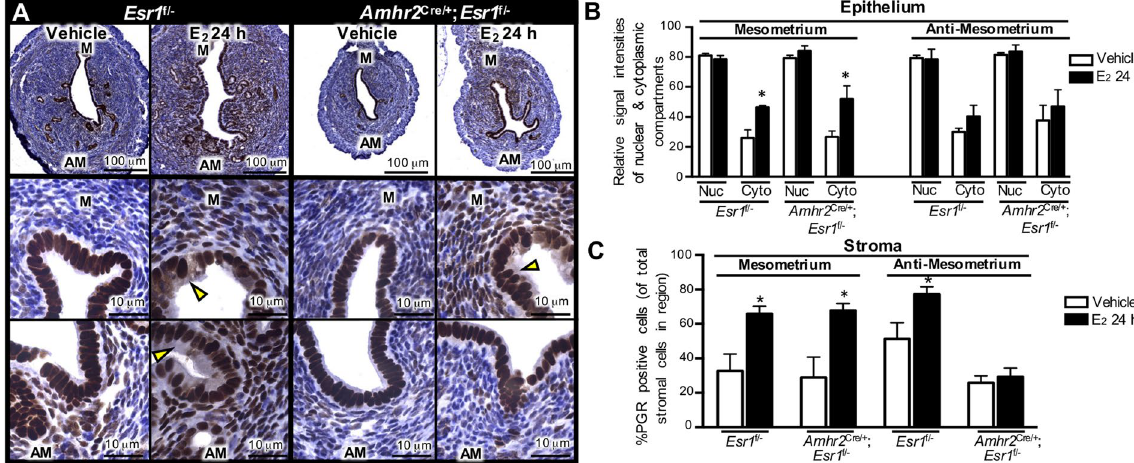
Figure 4. E 2 -induced progesterone receptor (PGR) expression in the uterus. Adult (8–12-week-old) female mice were ovariectomized and treated with vehicle or E 2 for 24 h. ( A ) Top panel: Cross-sections of the whole uteri were stained with PGR antibodies. Bottom panels: PGR expression pattern in the mesometrial (M) vs. anti-mesometrial (AM) poles in Esr1 f/ − and Amhr2 Cre/ + ; Esr1 f/ − uteri. Representative images shown. ( B ) Relative signal intensities of nuclear (Nuc) and cytosolic (Cyto) compartments in the uterine luminal epithelial cells of Esr1 f/ − and Amhr2 Cre/ + ; Esr1 f/ − uteri after vehicle and E 2 treatment for 24 h. ( C ) Percentage of